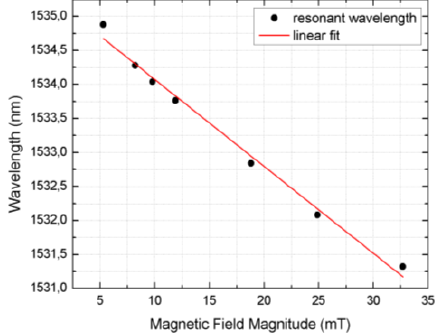
Fig. 3. Peak wavelength as a function of field